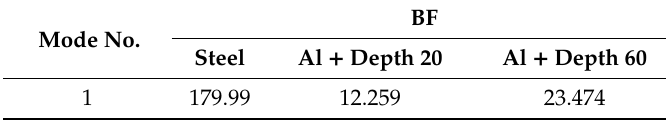
Table 6. Buckling factor for different cases of compartments.